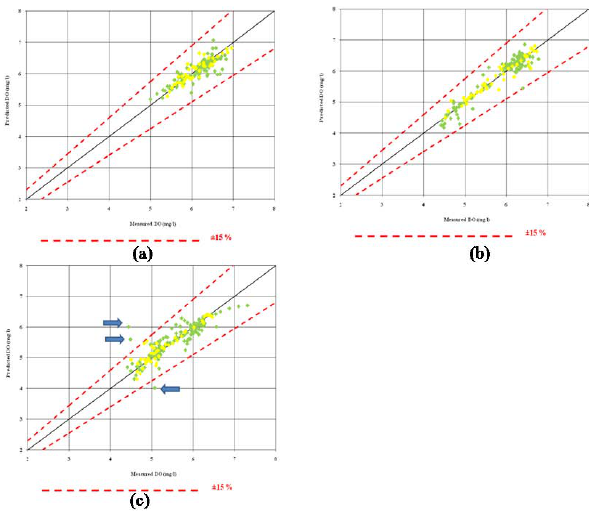
Fig. 12. Scatter diagrams of the predicted versus observed DO for validation (in green dot) and testing (in yellow dot); (a) DO-NN2, (b) DO-NN3 and (c) Do-NN4. Table 7. A summary of correlation coefficient for Scenario 1 and Scenario 2 and the AI